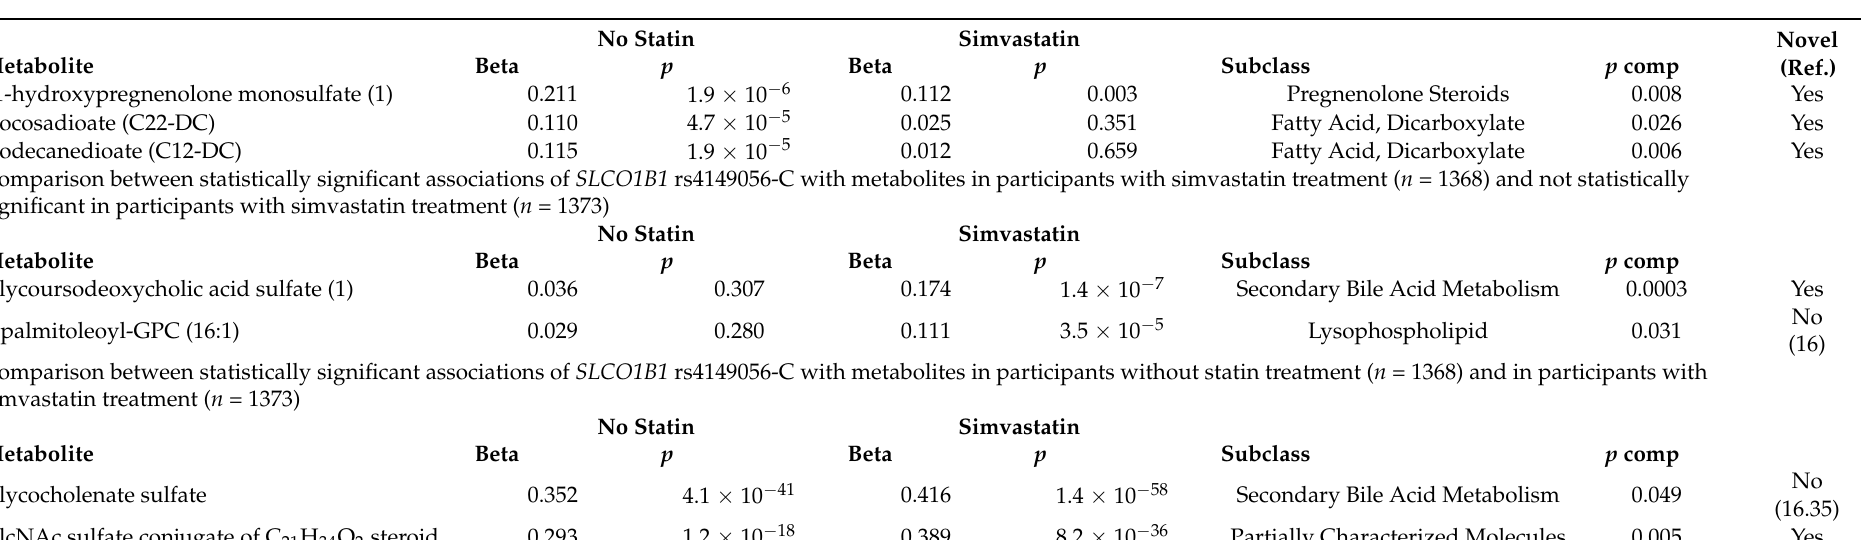
Table 2. Comparison between statistically significant associations of SLCO1B1 rs4149056-C with metabolites in participants without statin treatment ( n = 1368) and not statistically significant in participants with simvastatin treatment ( n =